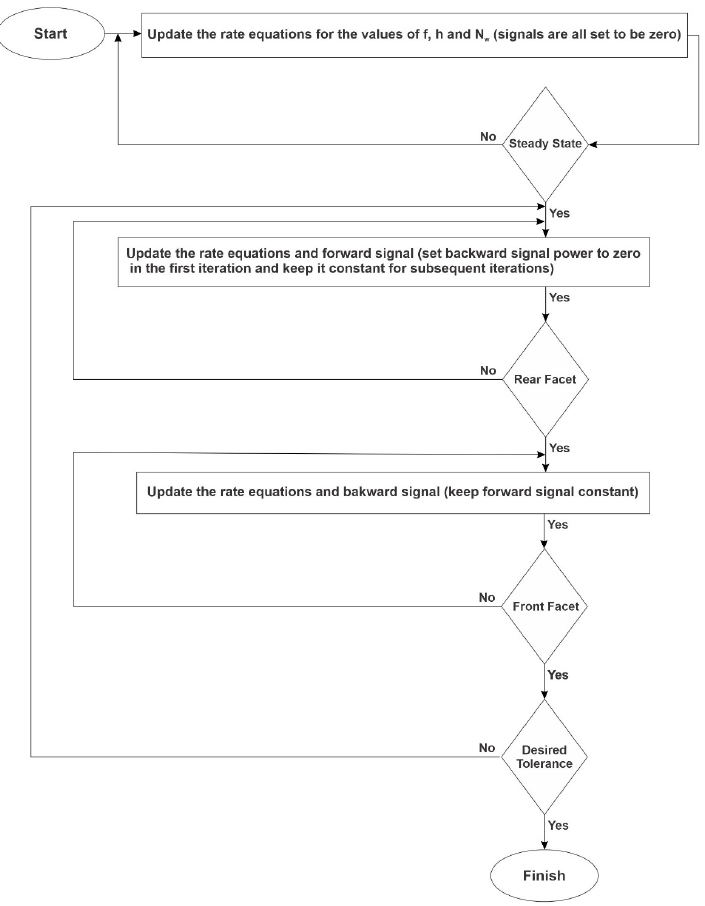
Figure 10. Flowchart for the proposed algorithm.